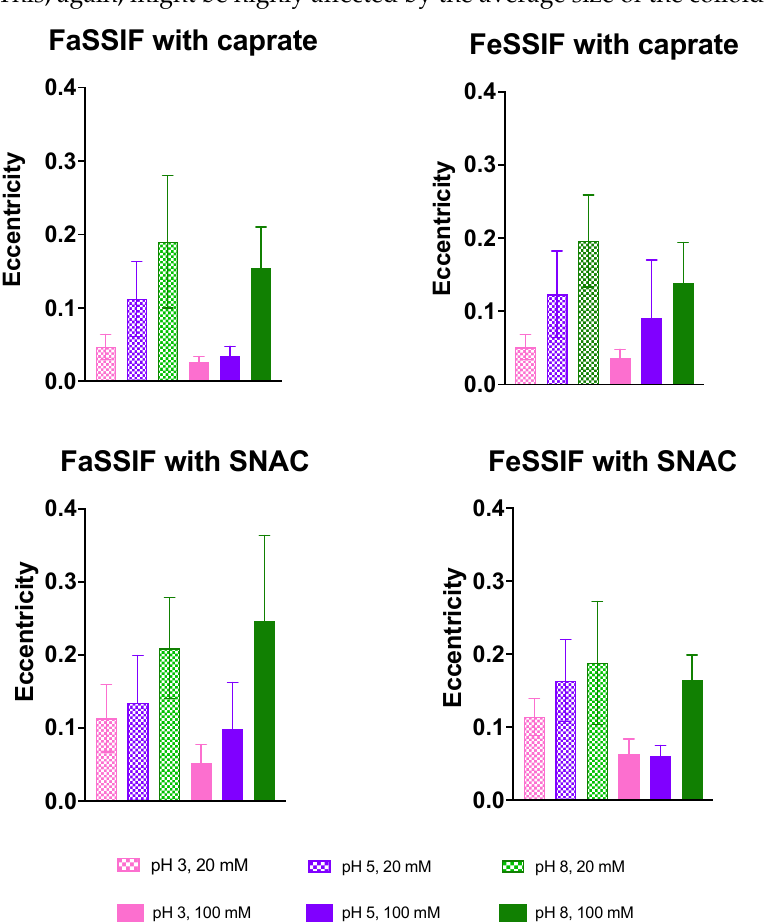
Figure 6. Eccentricity values for all studied systems, presented as an average value and standard deviation. Lower values indicate more spherical shapes. High values of the deviations reflect the effect of the fluctuations in the shape of the aggregates.